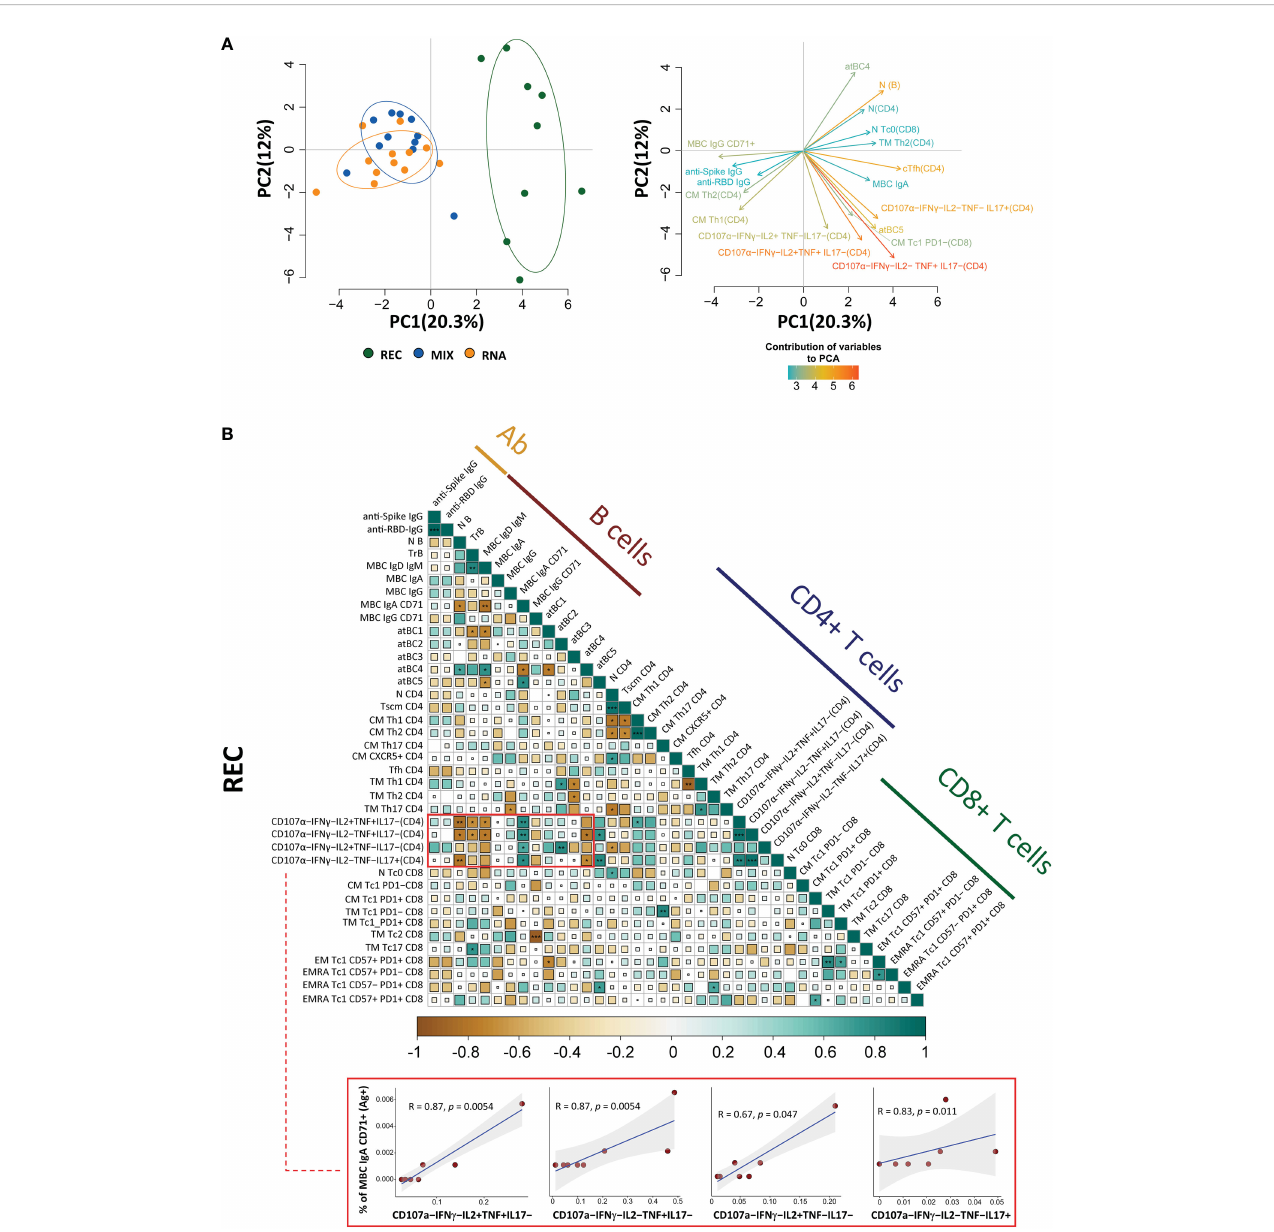
FIGURE 5 Principal component analysis and correlogram reveal that REC is different from MIX and RNA. (A) (Left) Principal component analysis (PCA) using the plasma level of anti-SARS-CoV-2 IgG antibodies, Ag-speci fi c T, B-cell percentages, and the fraction of polyfunctional CD4 + T cells from REC, MIX, and RNA subjects. REC, green circles (n = 9); MIX, blue circles (n = 11); RNA, orange circles (n = 12). (Right) Contribution of the different variables to PCA. The color of the arrows underlines the contribution level, while the position underlines the positive or negative contribution. Negatively correlated variables are positioned on opposite sides of the plot origin (opposed quadrants). (B) Correlogram of REC. Spearman R ( r ) values are shown from brown ( − 1.0) to green (1.0); color intensity and areas of square are proportional to correlation coef fi cients R. Spearman rank two-tailed P-value was indicated by *P < 0.05, **P < 0.01, and ***P < 0.001. Additional XY scatter plots that speci fi cally show the relationship between the variables that are most correlated are displayed. Each scatter plot reports the regression line (blue), the Spearman R ( r ) value, the exact two-tailed P-value, and the 95% con fi dence bands (light